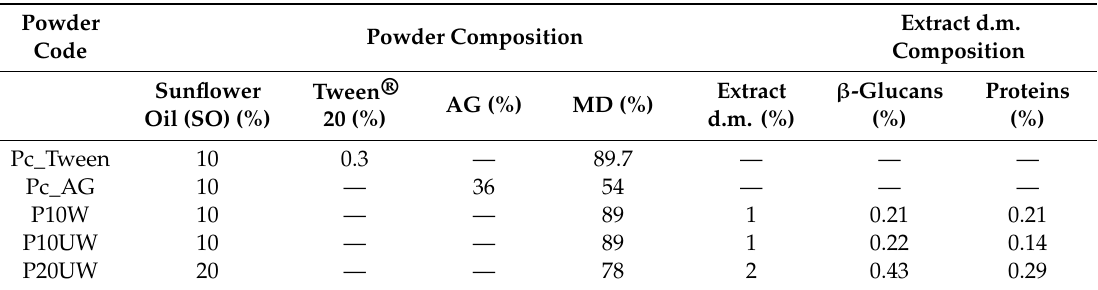
Table 1. Composition of the powders used for the study and β -glucans and proteins content of dry matter in the